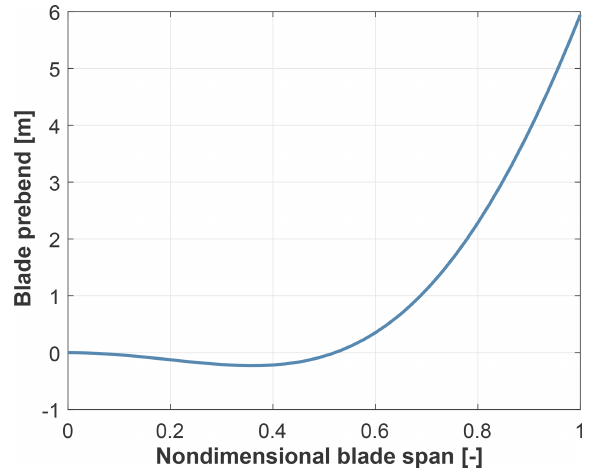
Figure 2. Prebend distribution obtained by Cp-Max during the re- design of the 10MW DTU RWT.